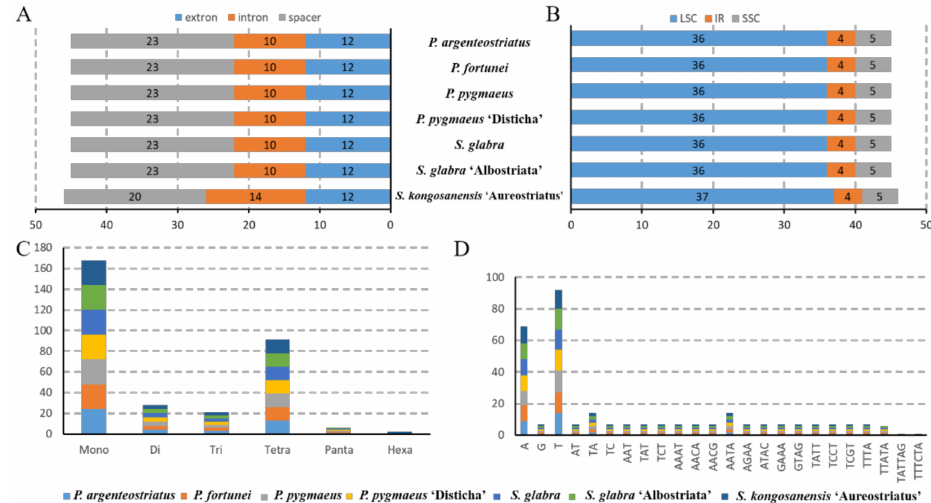
Figure 3. The type and distribution of SSRs in the chloroplast genomes of seven ornamental bamboo species. ( A ) Ratio of SSR distribution in different species. ( B ) Frequency of SSR occurrence in the long single-copy region (LSC), short single-copy region (SSC), and inverted repeat regions (IR).